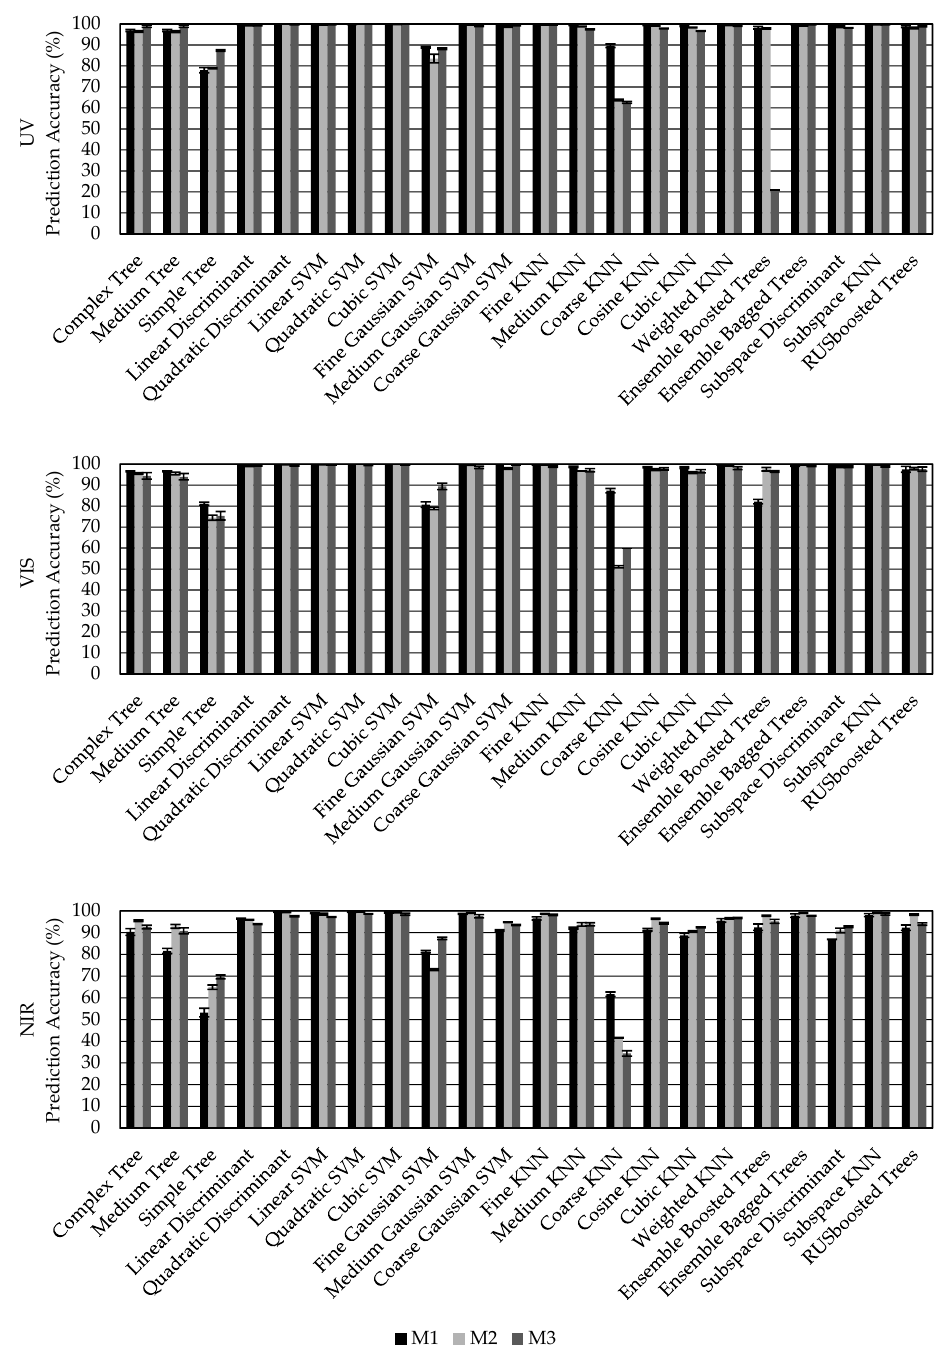
Figure 9. Prediction accuracy for 22 turn-key machine learning algorithms applied to reflectance intensity data collected using UV (top), VIS (middle), and NIR (bottom) spectrometers of six distinct targets and three different methods of ambient light compensation. M1 represents automatic adjustment of the integration time. M2 represents the result of M1 divided by integration time. M3 represents the result of M2 divided by ambient light energy on a wavelength basis. Bars represent average prediction accuracy. Error bars represent ±1 standard deviation.